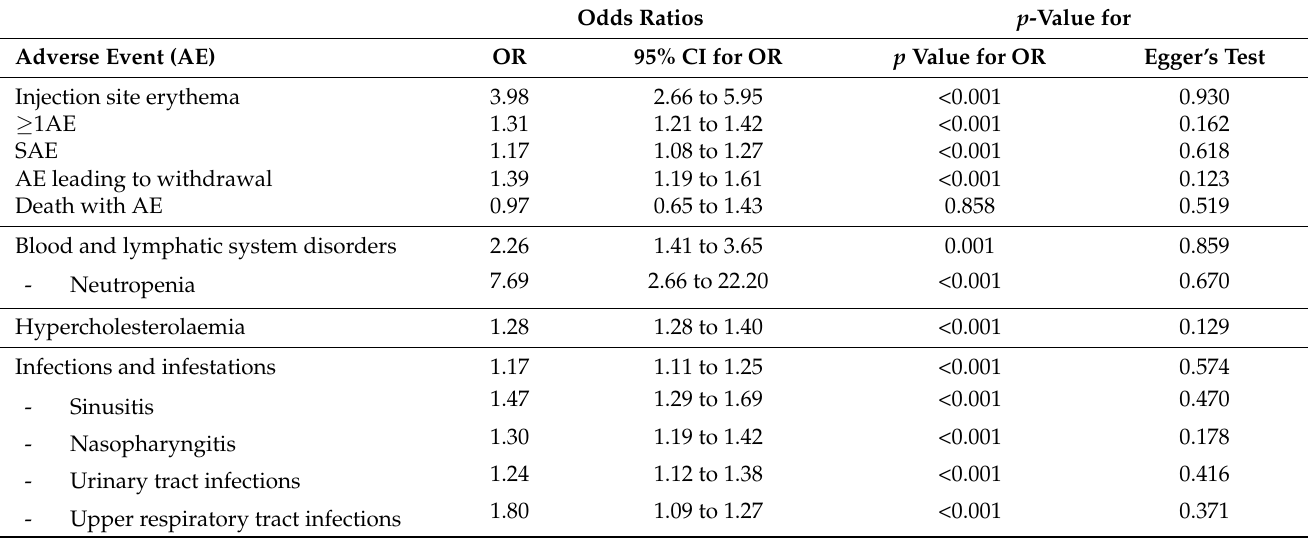
Table 4. Total (random/fixed effect) OR with 95% confidence intervals and p values, together with p -values of Egger’s tests. For ORs, p < 0.05 indicates a significant difference between prevalences in placebo and verum groups. With p < 0.05, Egger’s tests indicate a possible publication bias (highlighted in bold